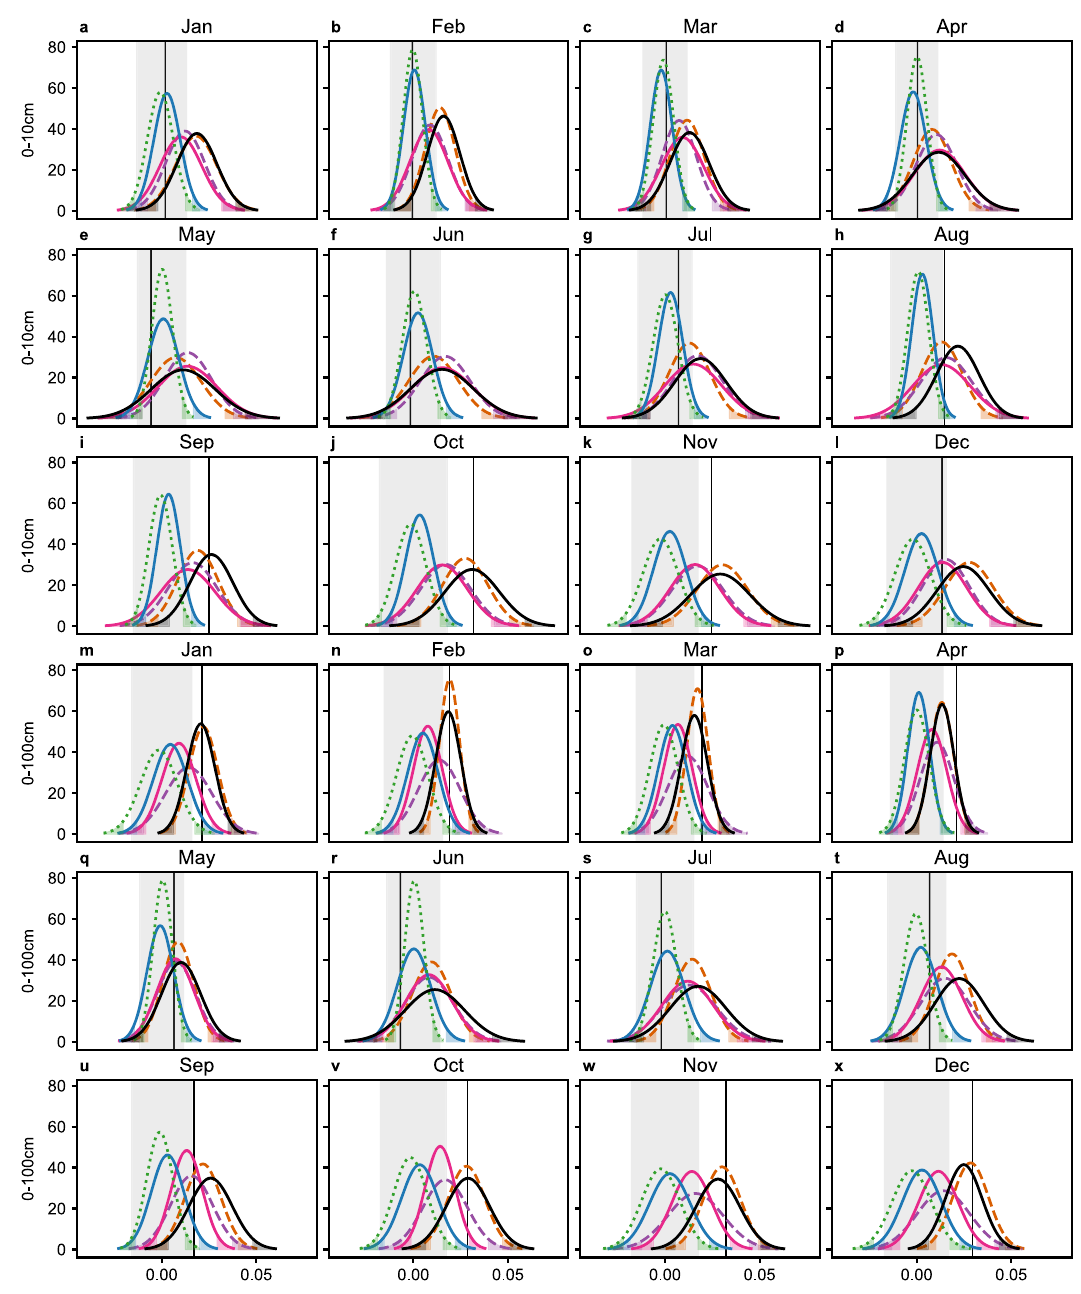
Fig. 3| Monthlydetectionandattributionofthepseudo-observed signalsover 1971 – 2016 in the 0 – 10cm and 0 – 100cm soil layers. a – x Vertical black lines represent the pseudo-observedsignals. Gray shaded verticalregions represent the 95% con fi dence intervals of the unforced trends. Bell-shaped lines represent the fi tted Gaussian distributions on the simulated signals of the various forced CMIP6 simulations: ALL (black solid, forced by all anthropogenic and natural for- cingagents),ANT(browndashed,forcedbyanthropogenicforcingsonly),GHGAER